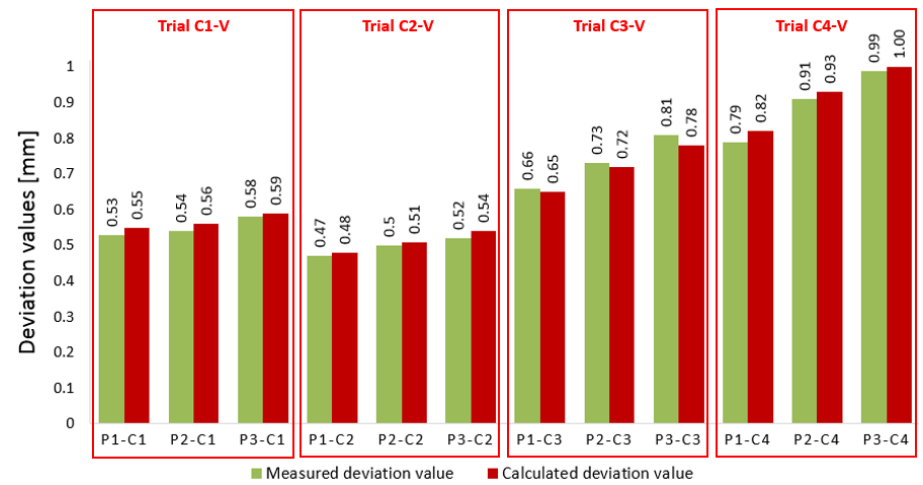
Figure 19. Graphical representation of the comparison between the predicted deviations and the deviations measured in the validation process, adapted with permission from ref. [5].